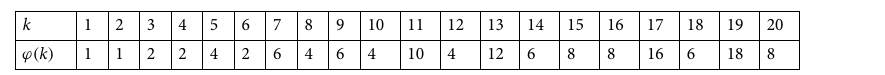
Table 1. Values of Euler’s totient function ϕ( k ) for all integers k between 1 and